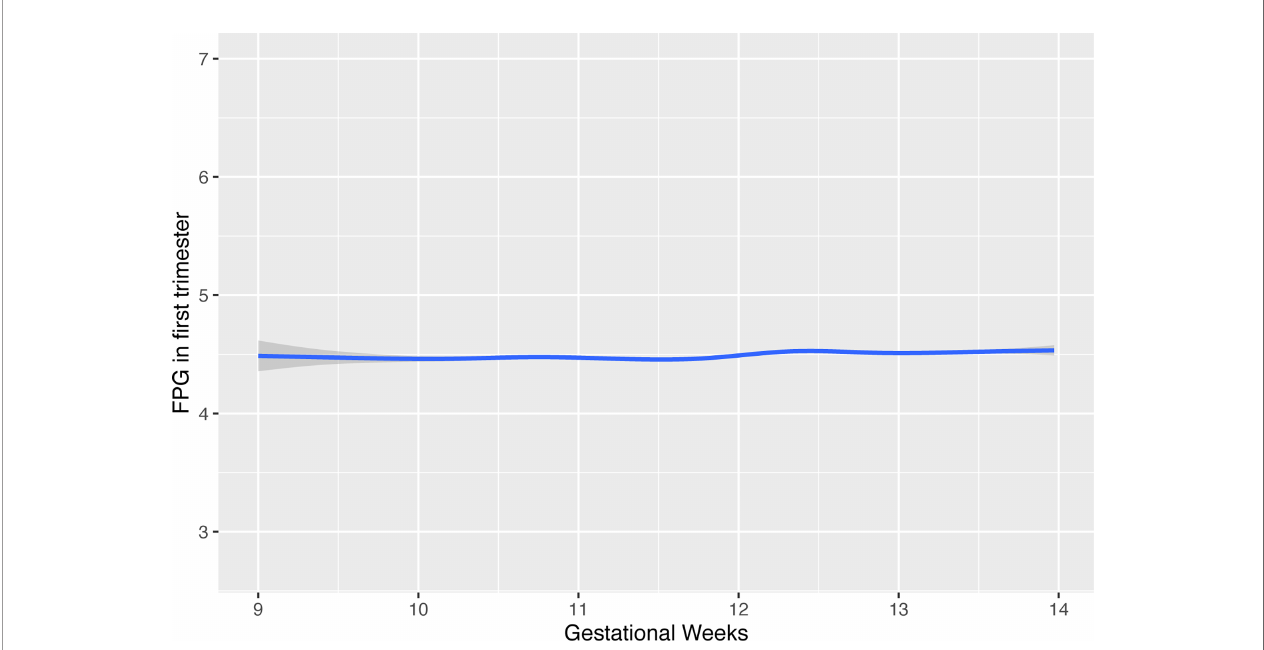
FIGURE 2 | The effect of timing in gestation for FPG values during early pregnancy. FPG, fasting plasma